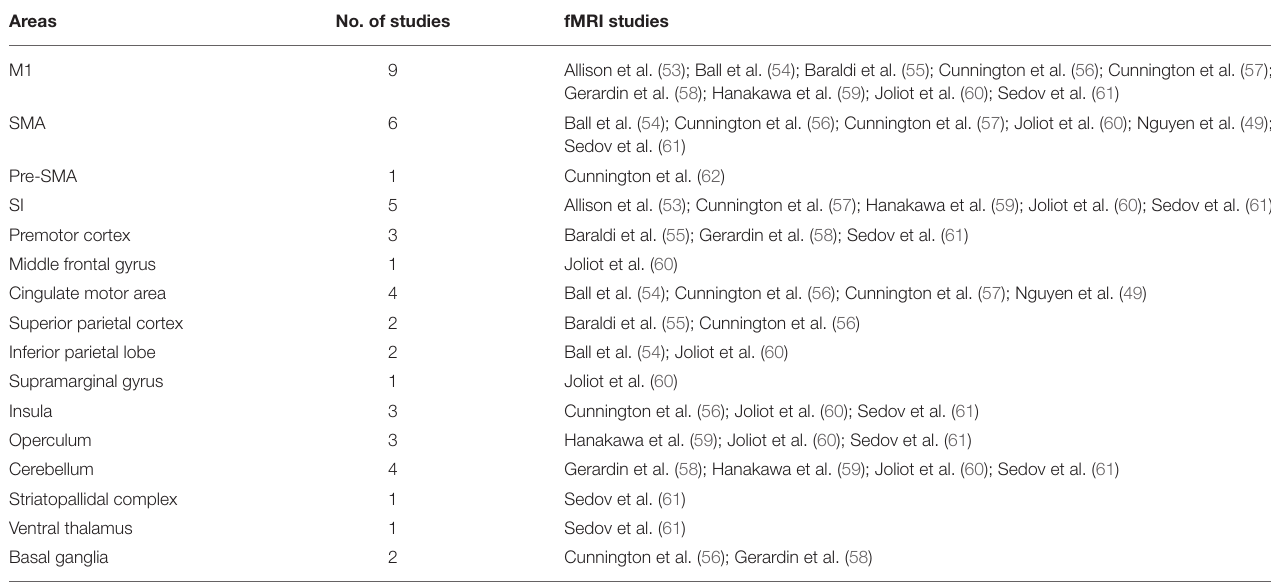
TABLE 2 | Activated areas during voluntary movements revealed by fMRI studies performed on healthy volunteers.